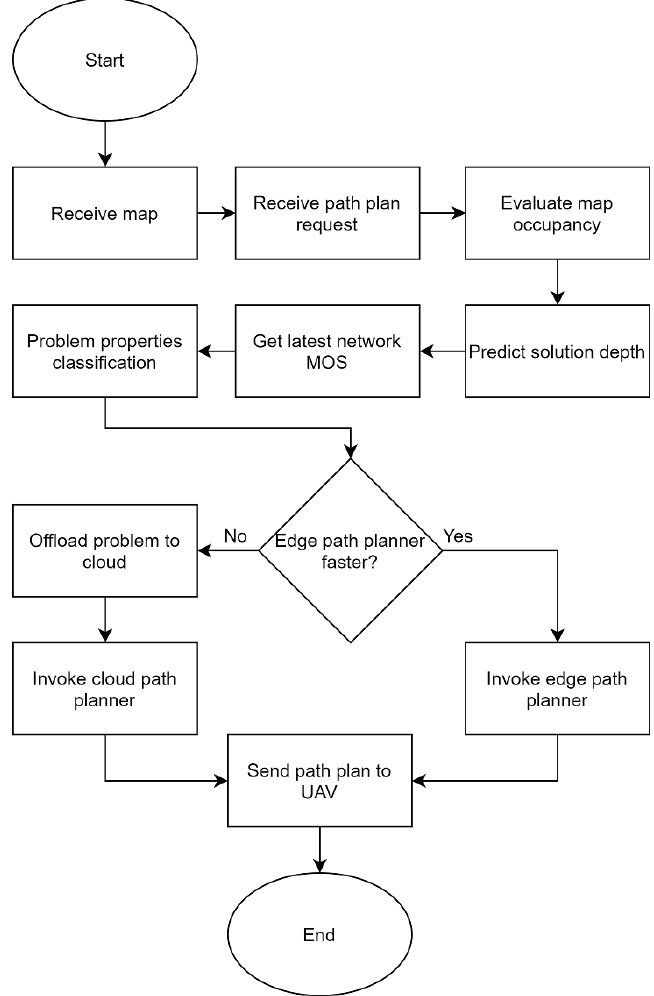
Figure 7. Flowchart of the offloading process.